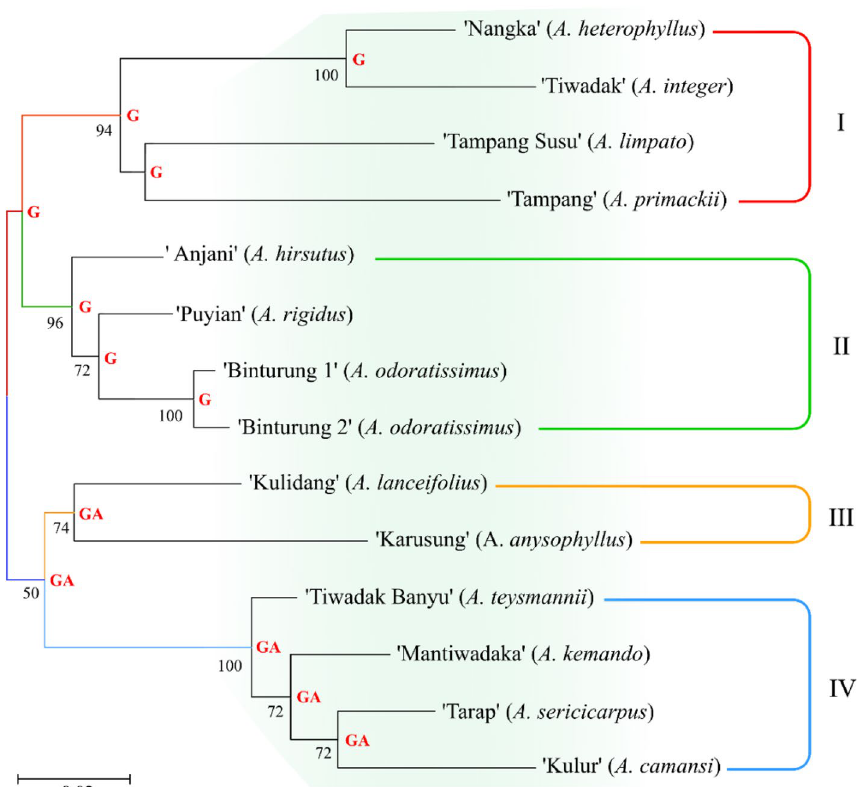
Fig. 6 The phylogenetic tree shows the grouping of endemic breadfruit ( Artocarpus spp.) from South Borneo, Indonesia, into four main clades. Values and letters (nucleotides) on nodes indicate the bootstrap analysis 1000 times and possible ancestors,